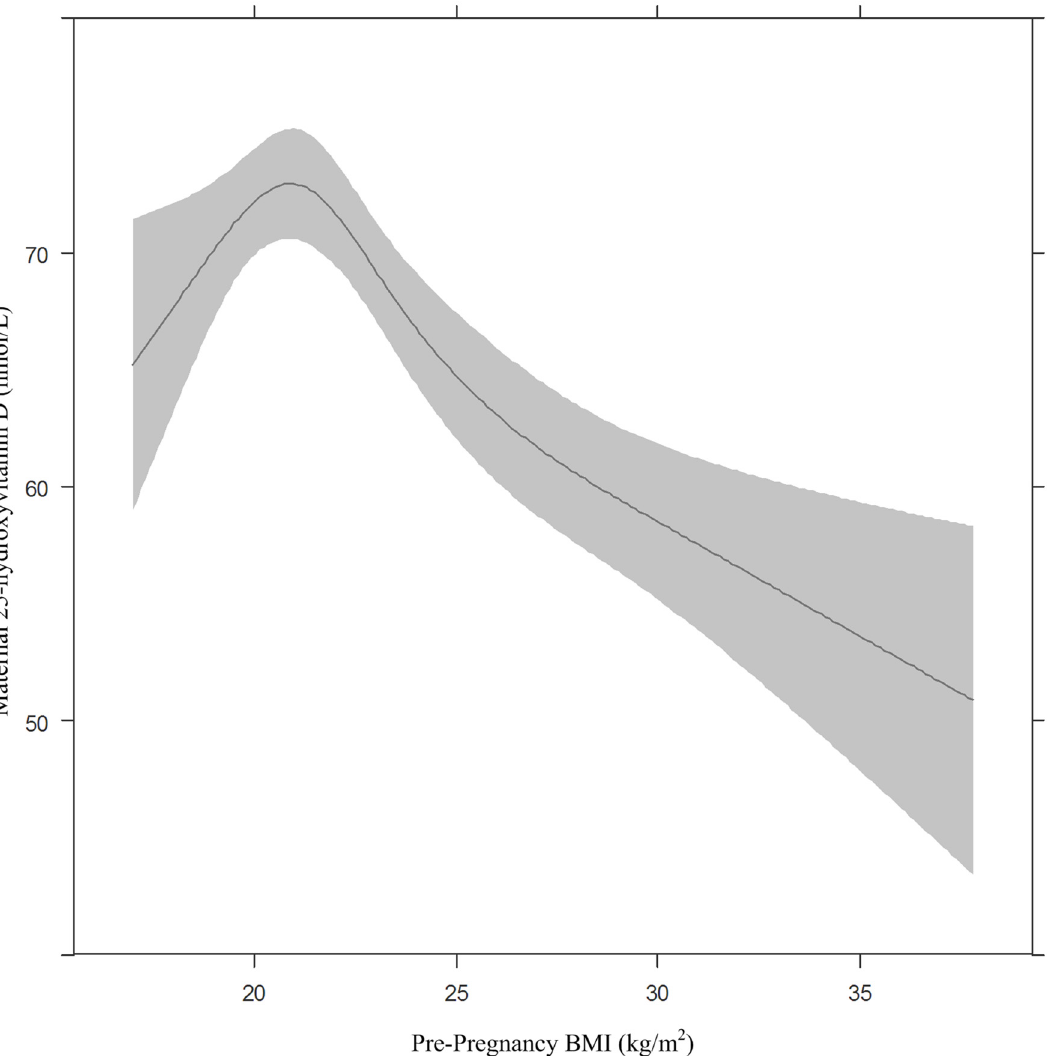
Fig 2. The association between maternal 25-hydroxyvitamin D concentration in early pregnancy and pre-pregnancy BMI. The association between maternal 25-hydroxyvitamin D and pre-pregnancy BMI modeled using restricted cubic splines. Adjusted for maternal age (31.9 years) and maternal education (10 years) and presented for Dutch ethnicity, nulliparous women and non-smokers